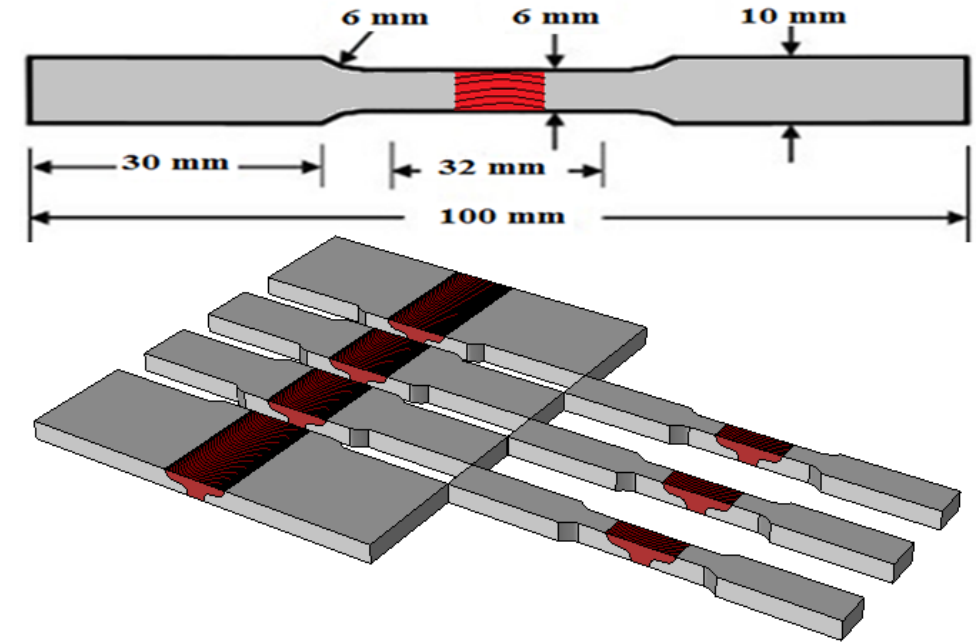
Figure 4. Schematic of tensile test specimens and related cutting position.